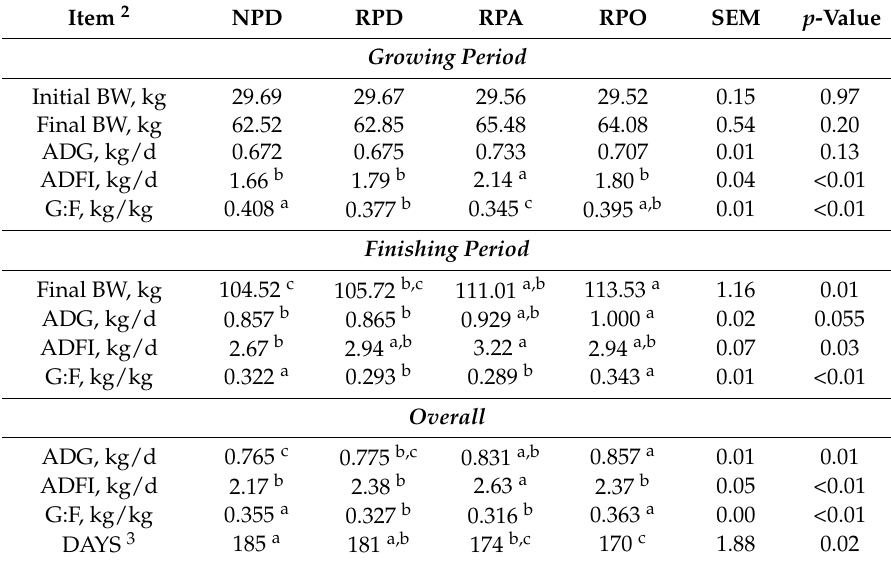
Table 2. Effects of supplementing oregano essential oil to a reduced-protein diet on growth performance of growing-finishing pigs 1 .